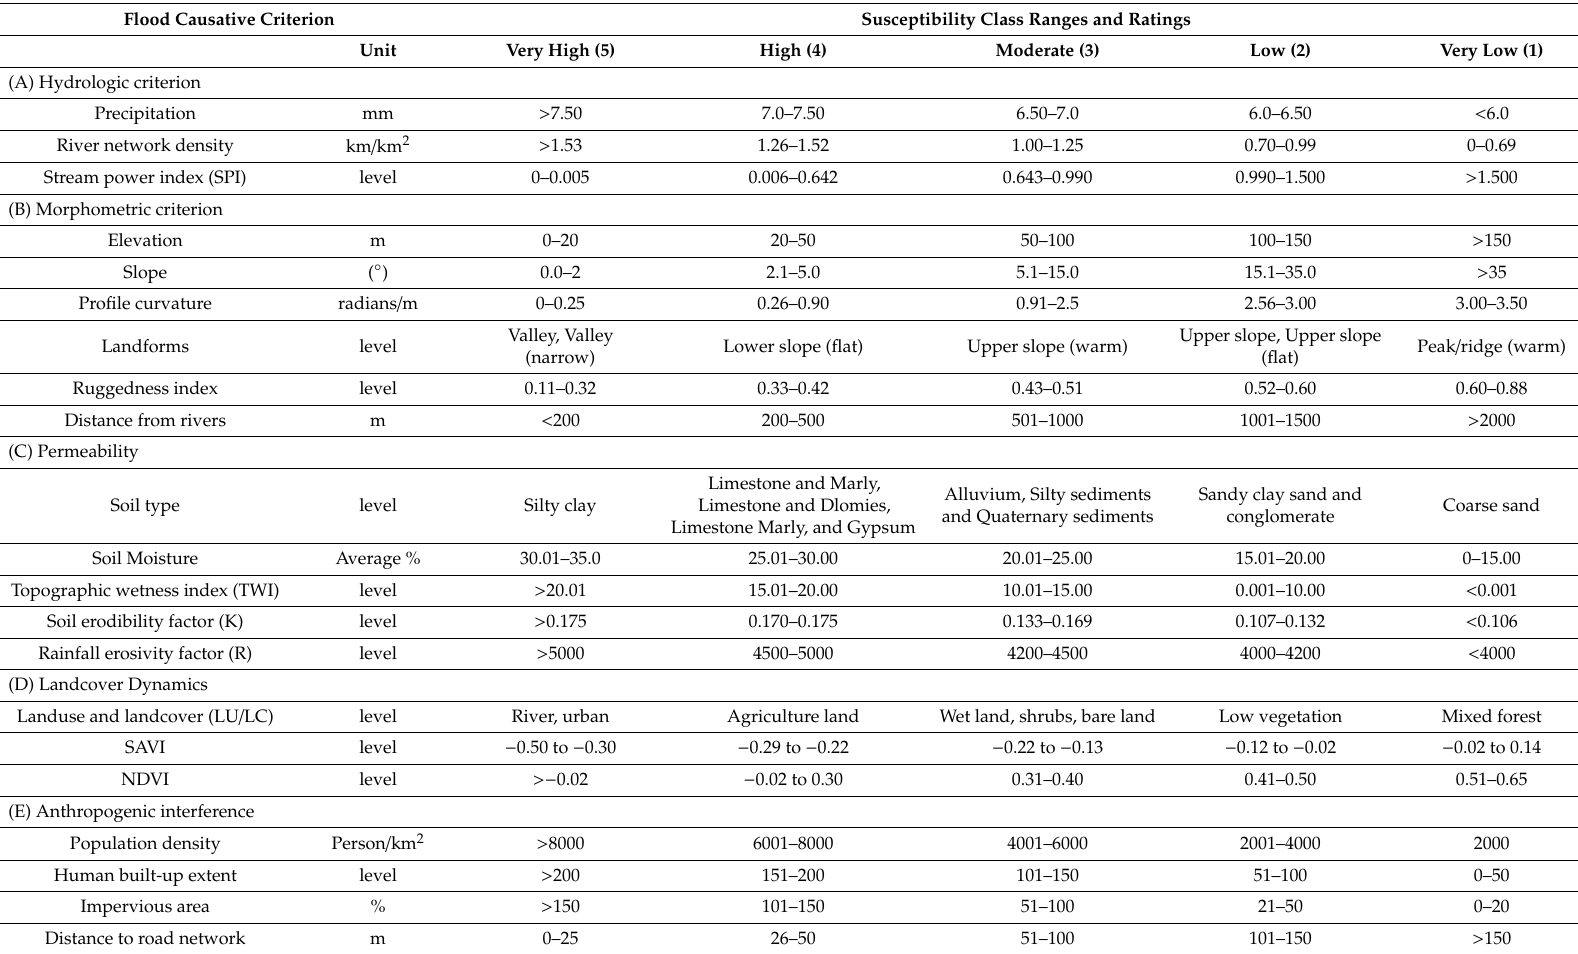
Table 3. Flood susceptibility criteria and sub-criteria ranges for flood susceptibility